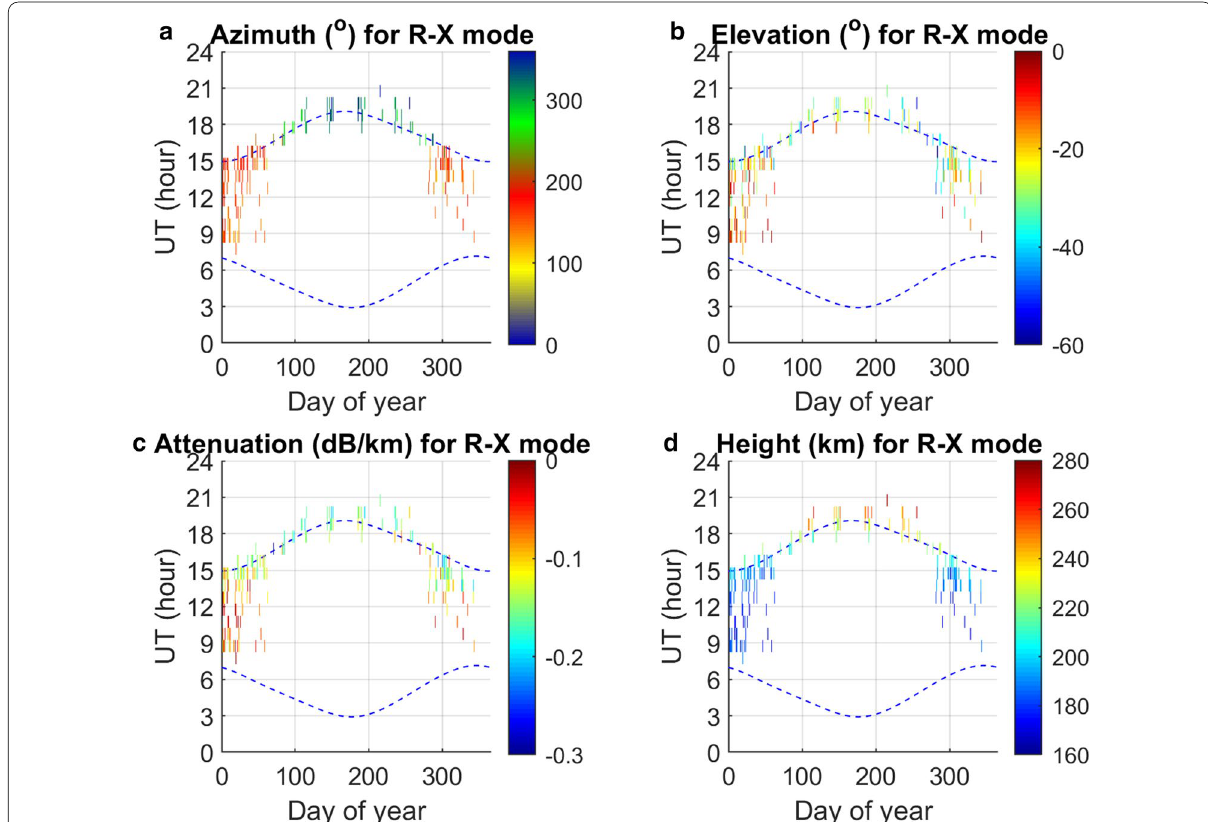
Fig. 5 Azimuth, elevation ǫ , attenuation A dBkm and height of observation for the period July 2014–June 2015 (solar maximum) and R-X mode. The values are color-coded. Dashed lines indicate times of sunrise and